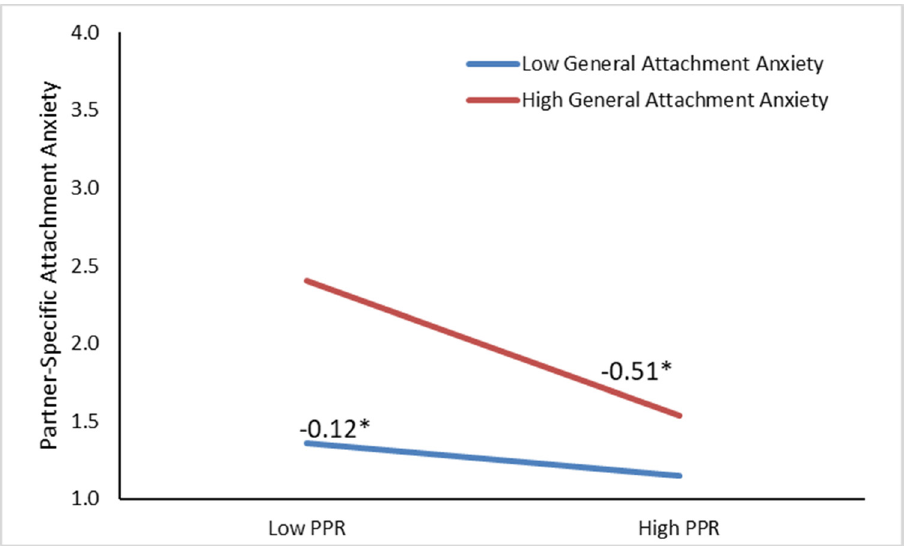
Figure 1. Predicting partner-specific attachment anxiety from perceived partner responsiveness as moderated by general attachment anxiety and controlling for partner-specific avoidance, age, sex, and study. PPR = Perceived Partner Responsiveness. * p < 0.05.